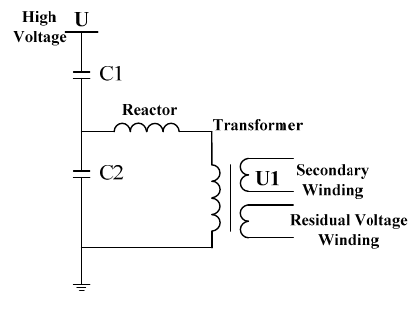
Figure 1. Structure diagram of CVT.